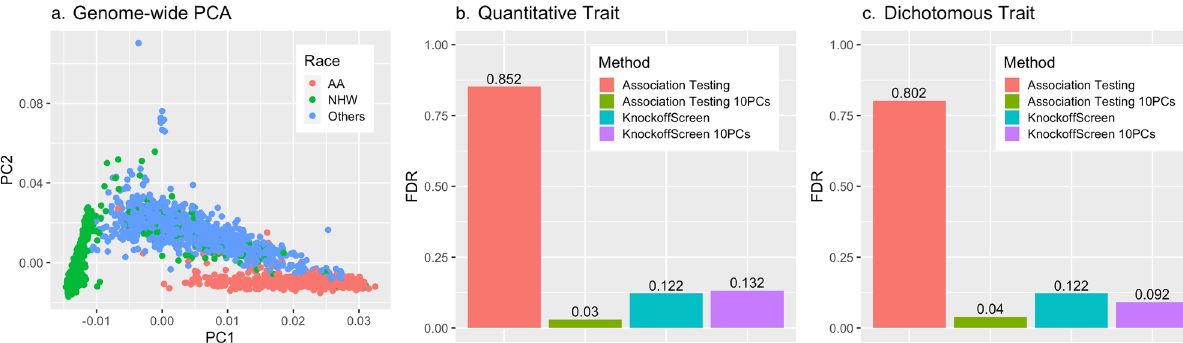
Fig. 5 Empirical evaluation of KnockoffScreen in the presence of population strati fi cation. a Principal component analysis of the ADSP data, which contains three ethnic groups: African American (AA), Non-Hispanic White (NHW), and Others (of which, 98% are Caribbean Hispanic). Each dot represents an individual. b , c Simulation results for the FDR control in the presence of population strati fi cation that mimics the ADSP data, comparing KnockoffScreen with conventional association testing. Each panel shows empirical FDR based on 500 replicates. KnockoffScreen 10PCs is a modi fi ed version of KnockoffScreen method that includes adjustment for the top principal components while computing the association statistics ( p -values). KnockoffScreen controls FDR at 0.10; Association Testing is based on usual Bonferroni correction (0.05/number of tests), controlling FWER at 0.05. Source data are provided as a Source Data fi